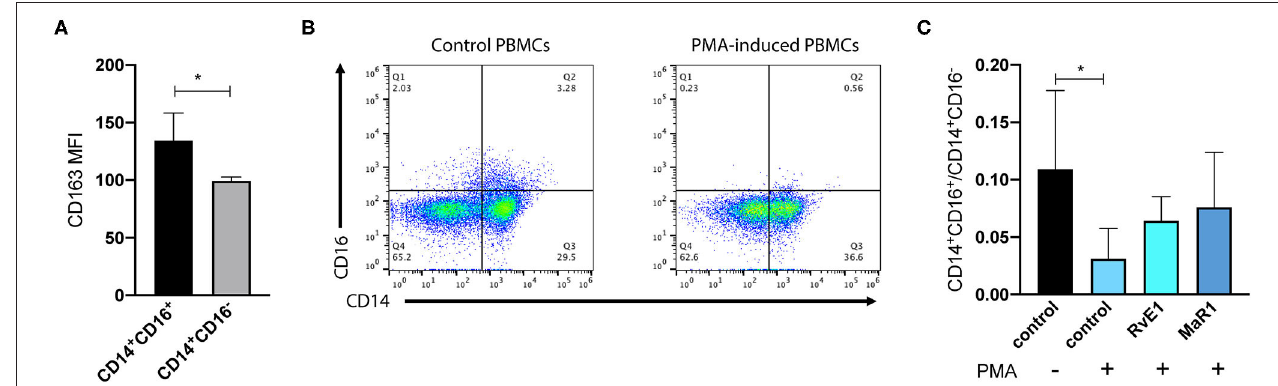
FIGURE 5 | CD14 + CD16 + /CD14 + CD16 − ratio as an indicator for the resolution of the inflammation. We freshly isolated peripheral blood mononuclear cells (PBMCs) from the Yorkshire pigs and stained with CD14, CD16, and CD163 markers. CD163 (a traditional M2 marker) was significantly higher in CD14 + CD16 + monocytes (nonclassical) compared to CD14 + CD16 − monocytes (classical) (A) ; MFI: median fluorescence intensity. For this reason, we argued that the CD14 + CD16 + /CD14 + CD16 − ratio served as an indicator for the resolution of the inflammation. To test this ratio, we differentiated PBMCs with phorbol 12-myristate 13-acetate (PMA) to the proinflammatory monocytes/macrophages and observed the reductions of CD14 + CD16 + monocytes (B) . CD14 + CD16 + /CD14 + CD16 − ratio was significantly reduced in PMA treatment and partially restored by SPMs (C) . This figure was a composite from two independent experiments. * p < 0.05.